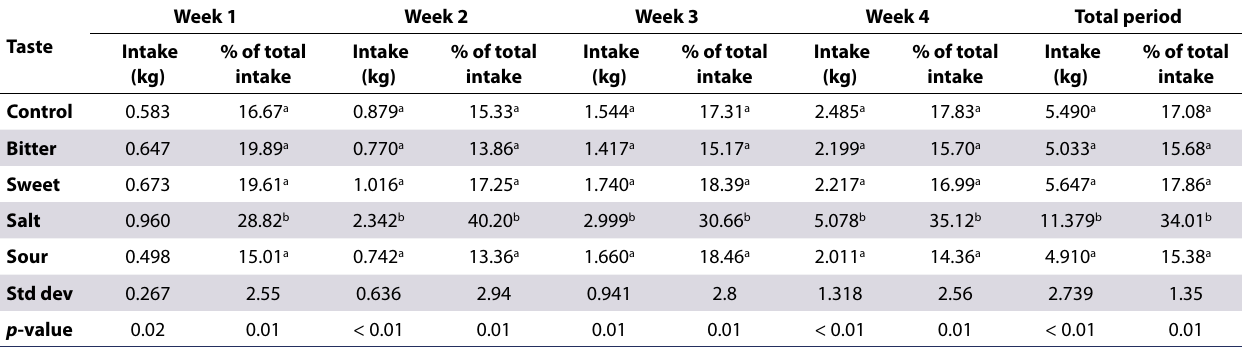
Table III: Distribution (%) of taste preferences as determined by feed intake in ostrich chicks (1–28 days of age) during Trial 1 Taste